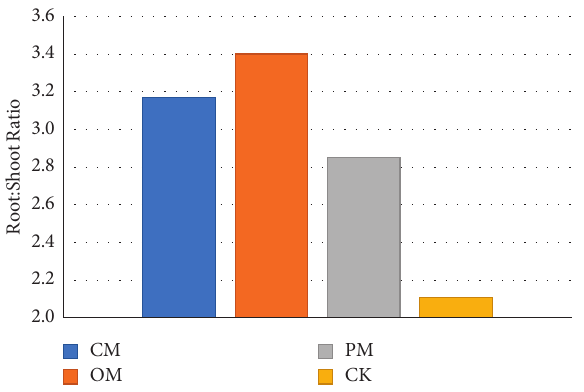
Figure 7: Root-shoot ratio among treatments.